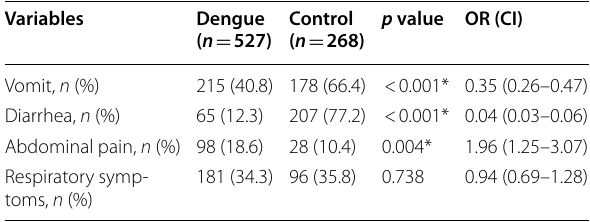
Table 2 Comparison of the clinical characteristic of dengue and